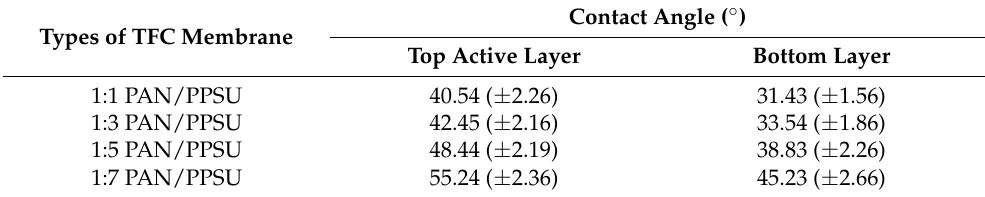
Table 3. Surfaces contact angle of TFC membranes.